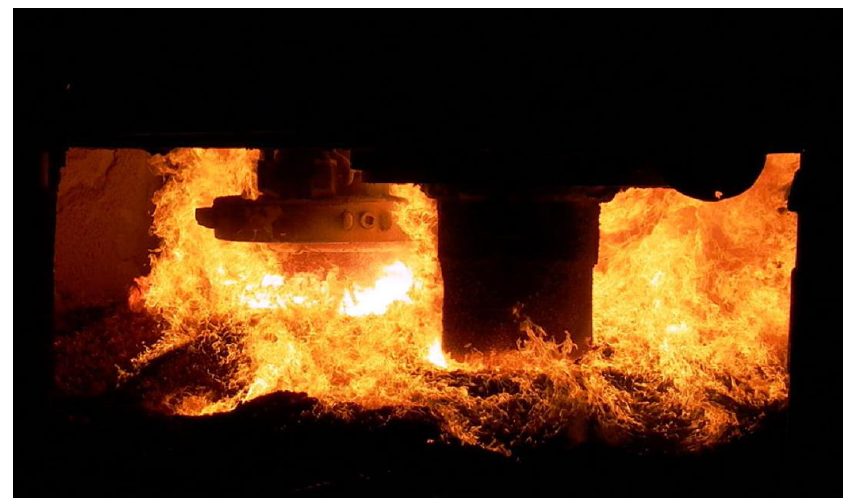
Figure 5. Picture of the upper part (zone 5, Figure 6) of a submerged ARC electrode furnace during process showing two electrodes in the center of the picture.